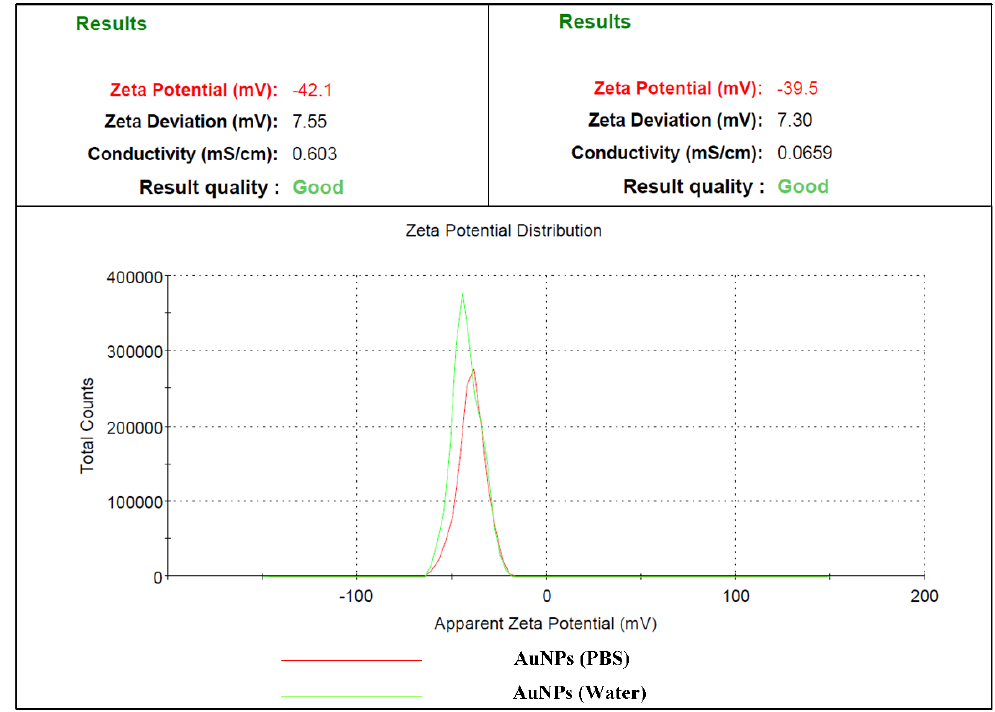
Figure 4. Zeta potential results of AuNPs suspension after 5 min of sonication. AuNPs dissolved in water (green solid line) and dissolved in phosphate-buffered saline (PBS) (red solid line).